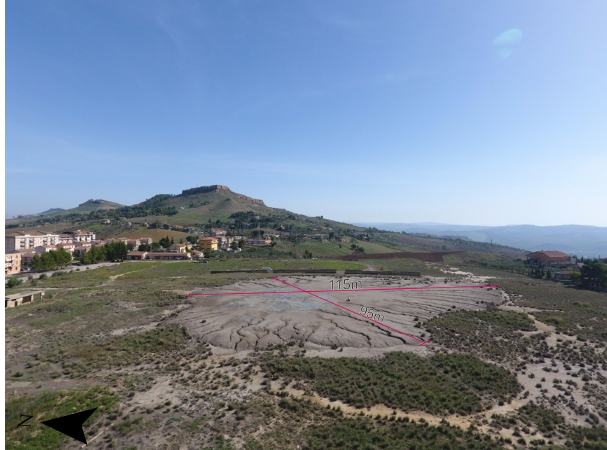
Figure 1. Aerial view of the Santa Barbara mud volcano. Photo taken by the UAV from the west side of the mud volcano.